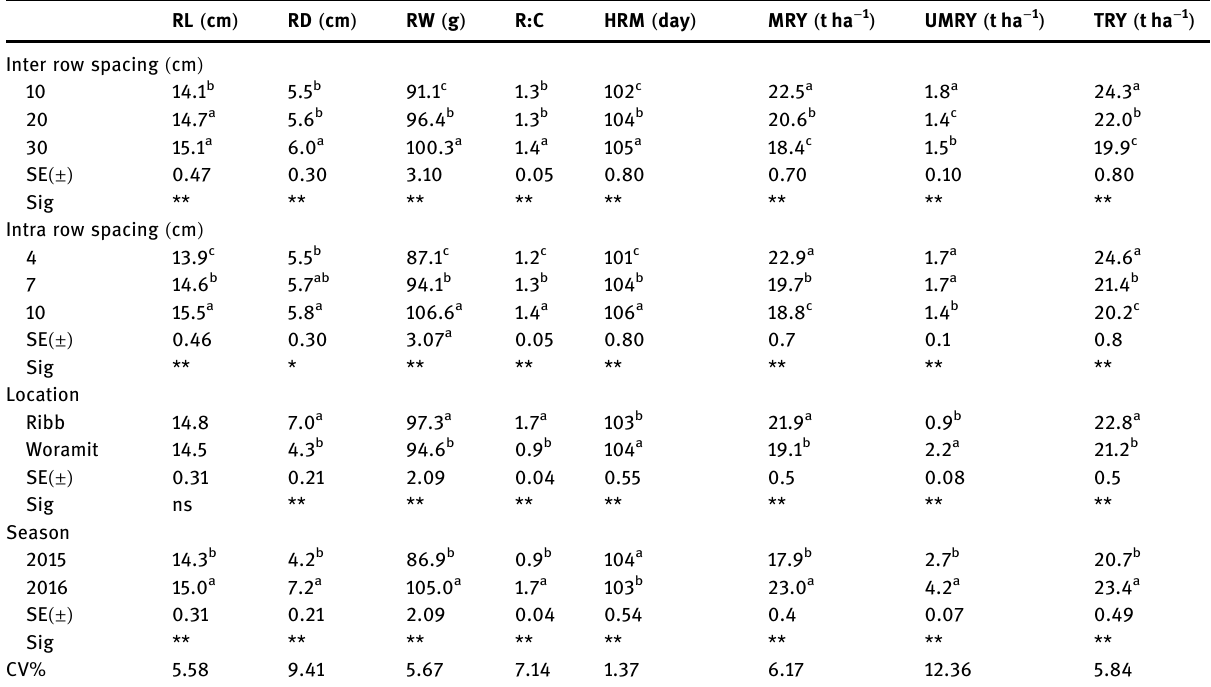
Table 2: Main e ff ects of spacing, location, and year on yield, yield components, and days to maturity of carrot